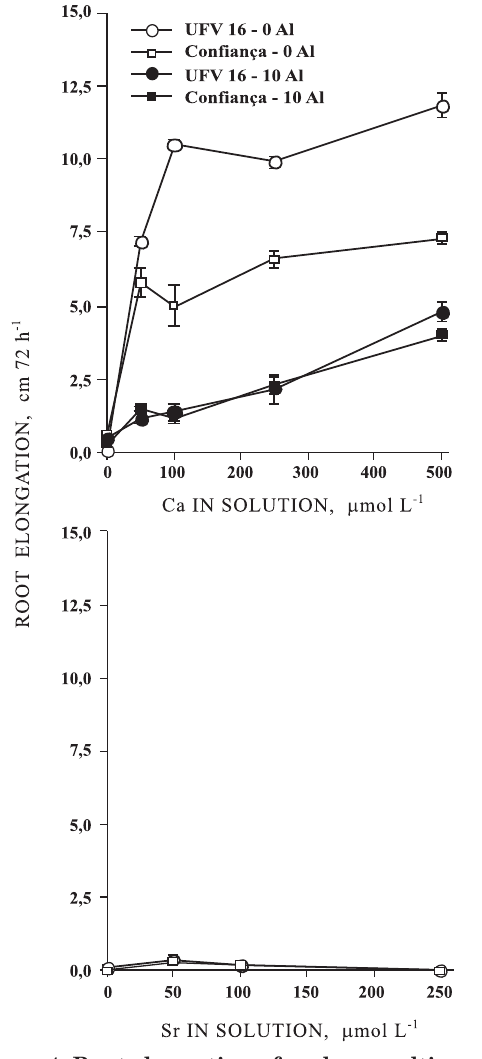
Figure 4. Root elongation of soybean cultivars UFV- 16 and Confiança as a function of increasing Ca (a) or Sr (b) in solution (pH 4.5), in the absence or presence of 10 μ mol L -1 Al. Error bars represent standard error (n = 3).